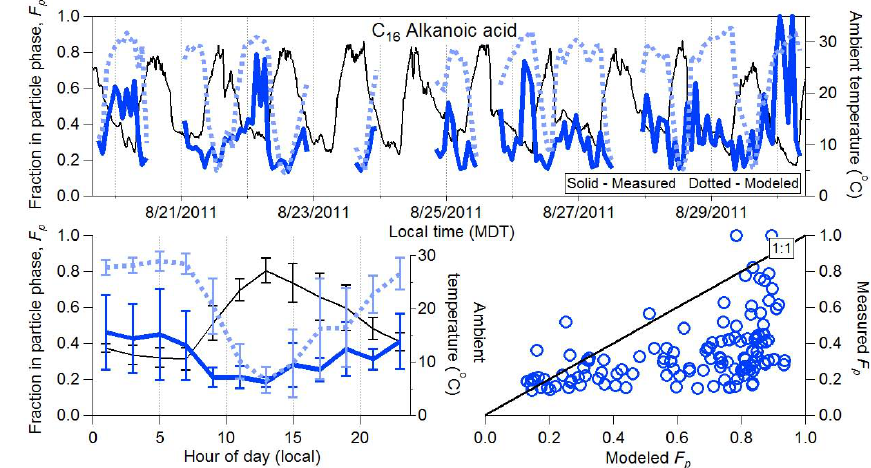
Fig. 11. Time series, diurnal cycle, and scatter plot of measured and modeled F p for C 16 alkanoic acid.